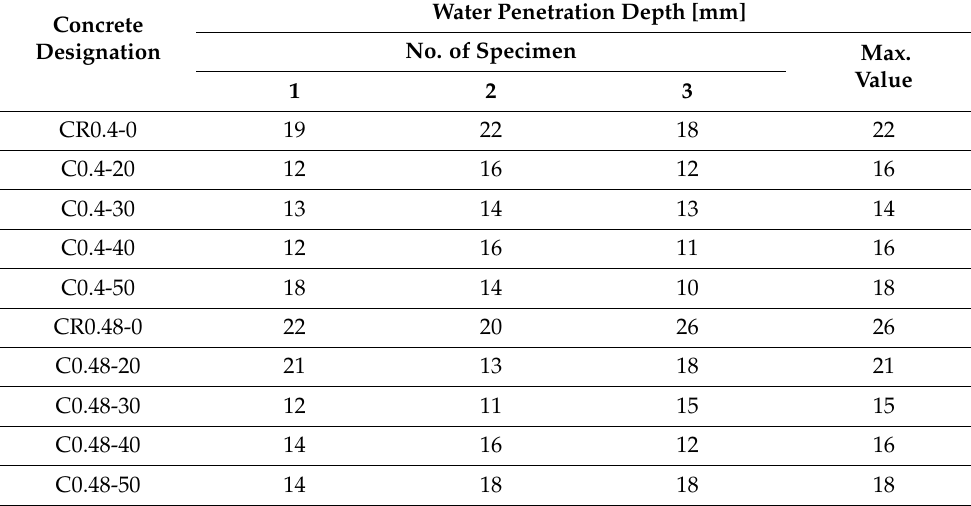
Table 6. Water penetration depth of